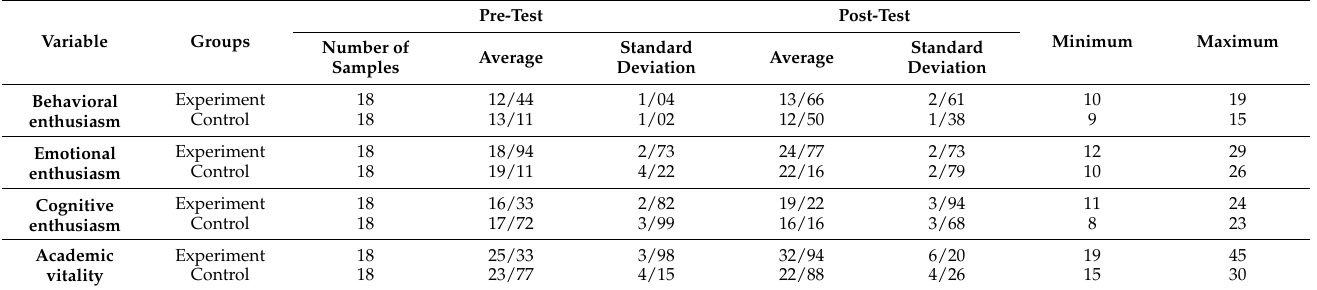
Table 2. Descriptive data of components of academic enthusiasm and academic vitality in pre-test and post-test according to control and experimental groups.